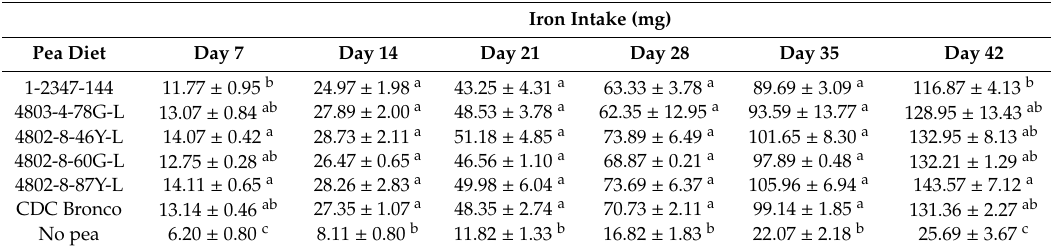
Table 5. Experimental cumulative iron intake 1 .